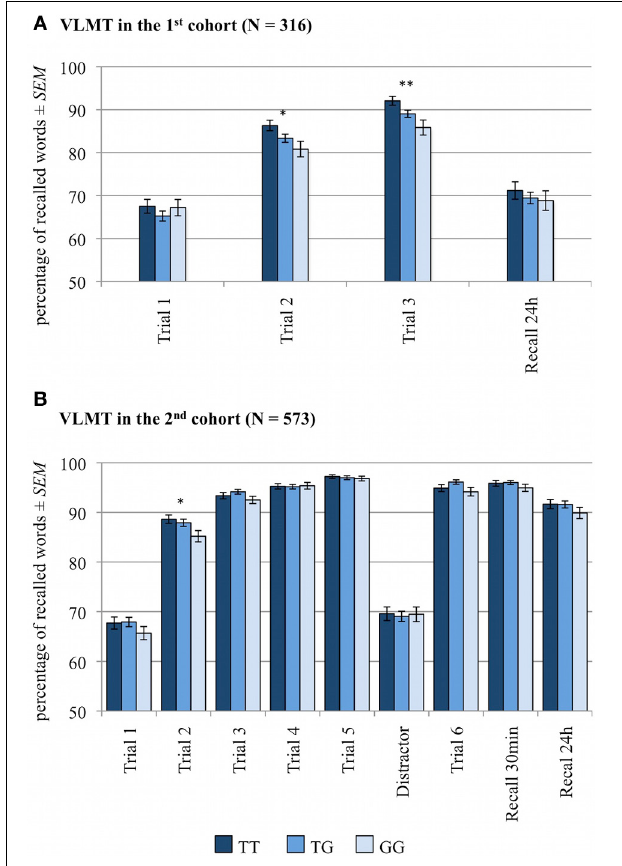
FIGURE 1 | Memory effect of RASGRF1 in Verbal Learning and Memory (VLMT). Higher % values indicate better memory performance. (A) In the first cohort we observed a significant positive correlation between T allele count and recall performance in the second and third learning trials. (B) In the second cohort we found a positive correlation between the T allele count and recall performance in the second learning trial. ∗ Significant at p < 0 . 05; ∗∗ Significant at p < 0 . 01.